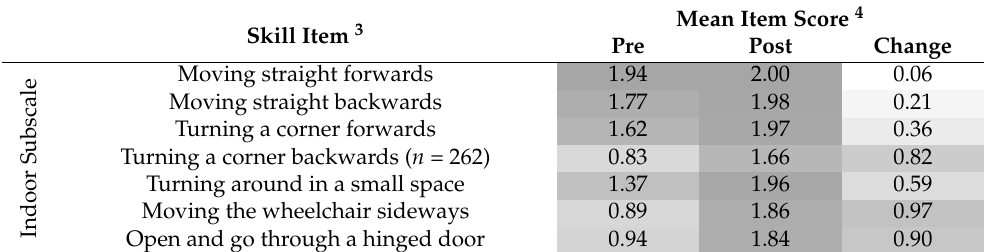
Table 3. WST-Q individual item mean scores (out of 2) 1 and ranking ( n = 307) 2